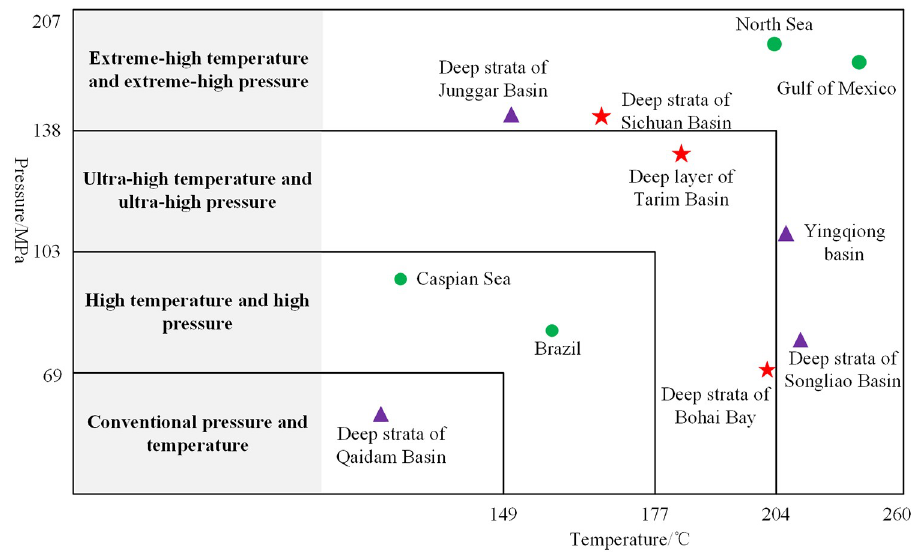
Fig 1. Pressure and temperature environment of some deep-well reservoirs at home and